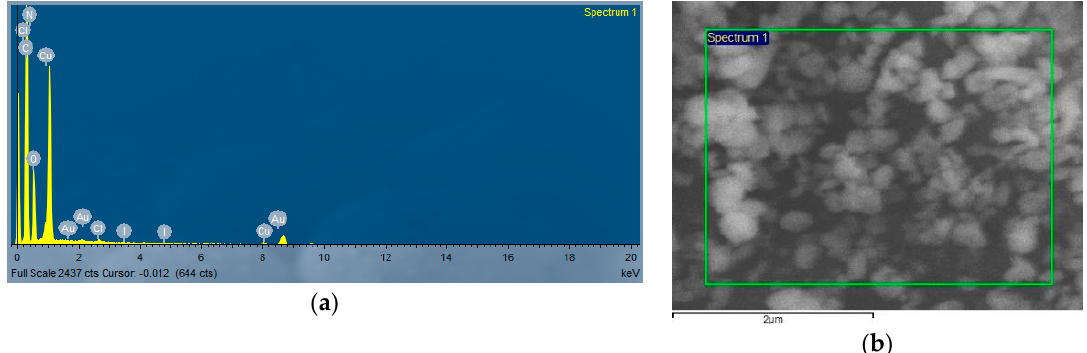
Figure 8. EDX graph of the polymer matrix ( a ), SEM image of the AuNPs in the polymer matrix ( b ).